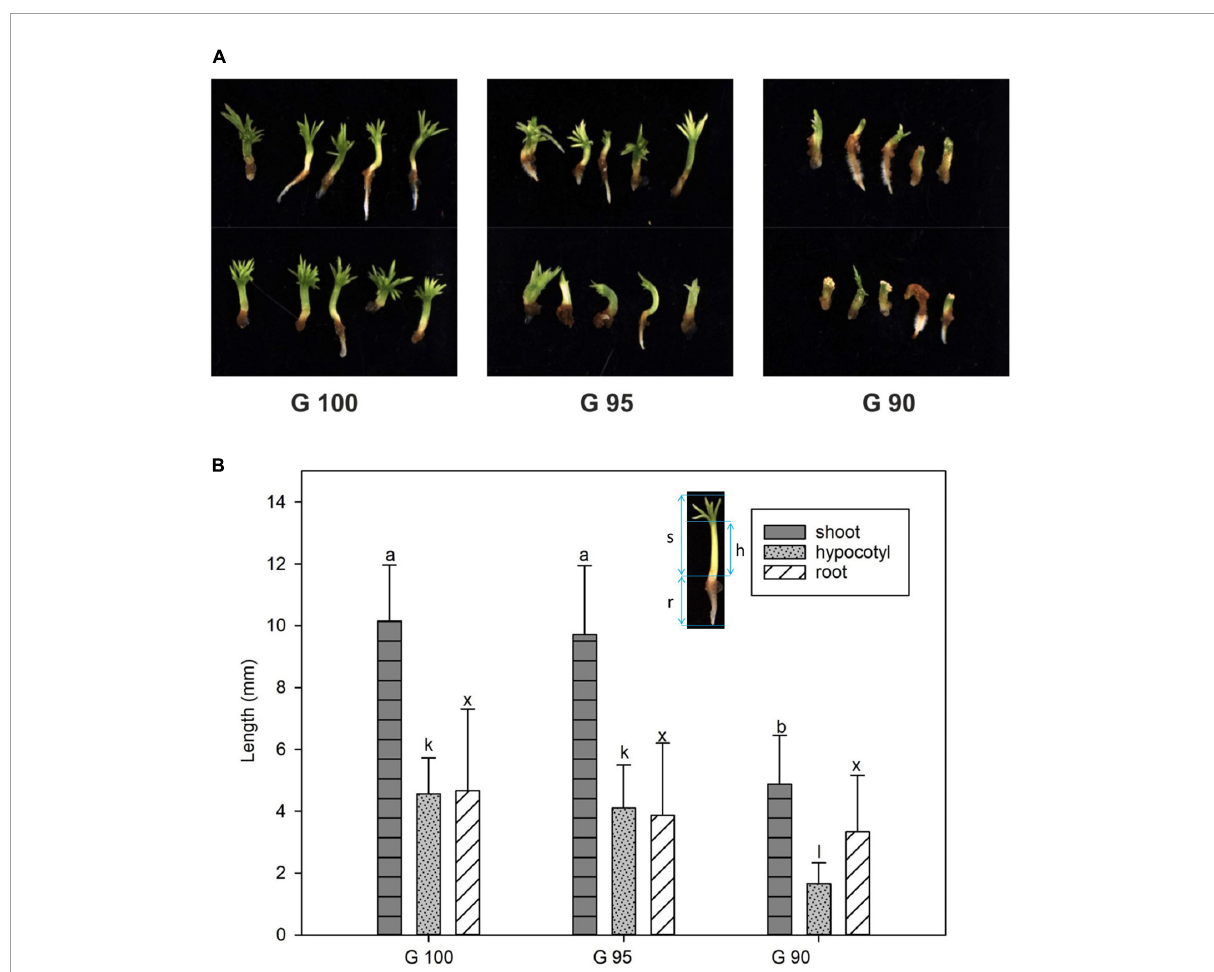
FIGURE3 Morphology of 3-week-old emblings developed from embryos desiccated at different relative humidity levels (G100, G95, and G90). (A) Overview of emblings; (B) Length of whole shoots (dark gray columns), hypocotyls (light gray columns), and primary roots (white columns). The image of the embling inserted in the graph (B) shows the measured parts – shoot (s), hypocotyl (h), and primary root (r). Values are given as means ± standard deviations ( n = 8) of four independent experiments. Different letters indicate a significant difference at p ≤